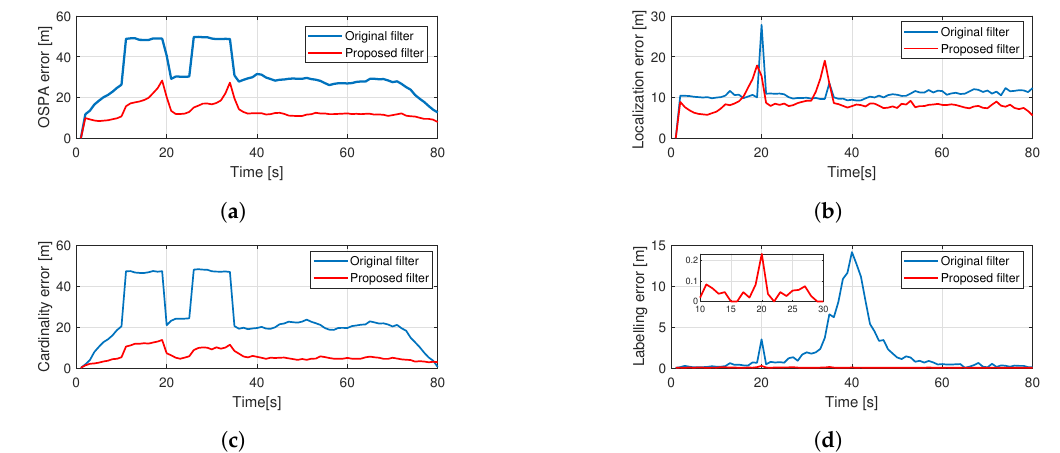
Figure 6. Averaged performance of 200 Monte Carlo simulations from the crossing trajectories scenario using the proposed PHD filter. Total OSPA error ( a ), localization error ( b ), cardinality error ( c ), labeling error ( d ).